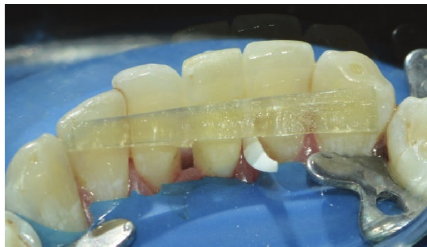
Figure 9: Immediate postoperative photograph.